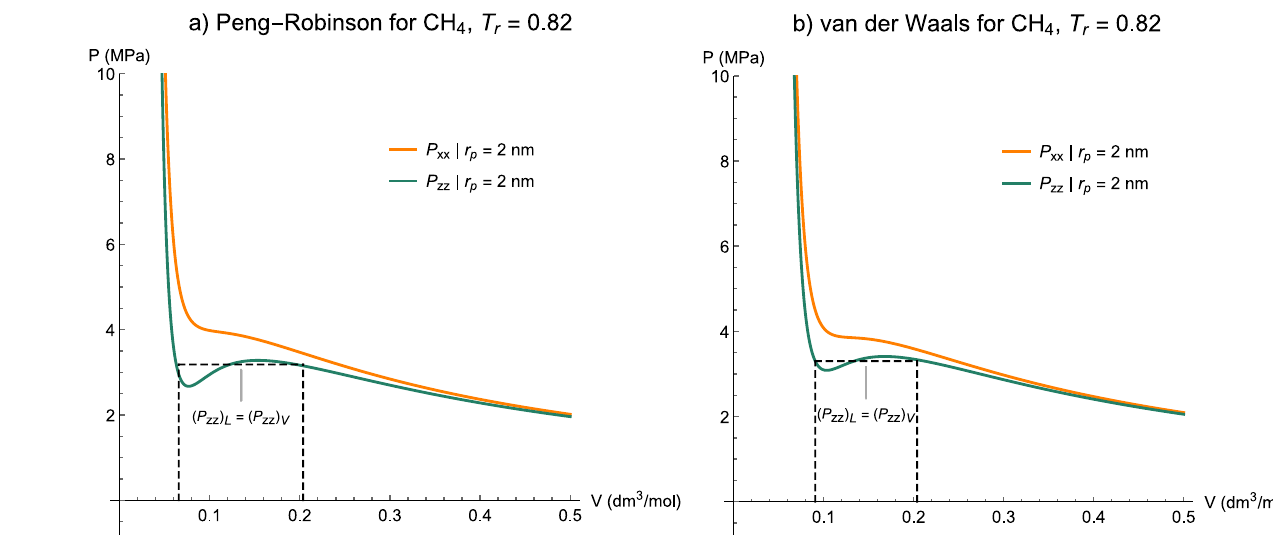
0.82 obtained from ( a ) Peng-Robinson =